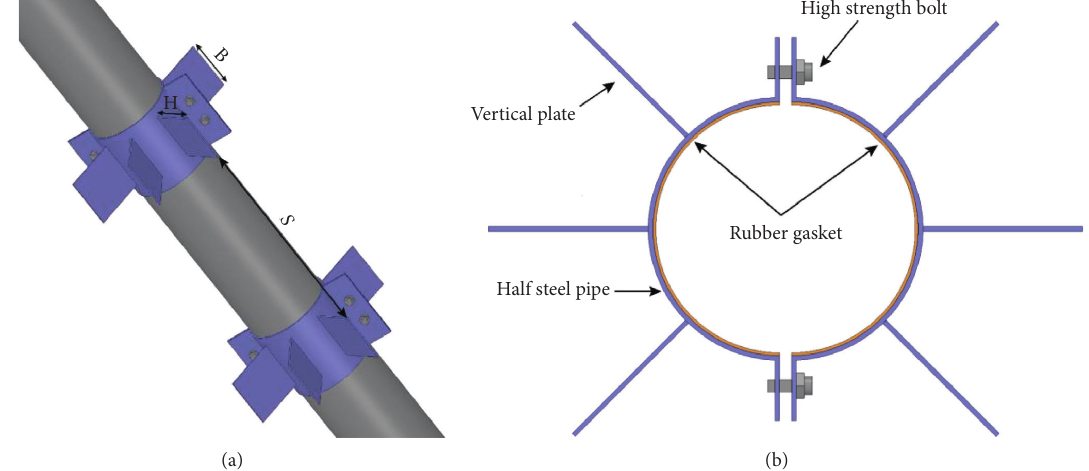
Figure 1: The design scheme of the new spoiler. (a) Basic parameters. (b) Geometric details of the spoilers.